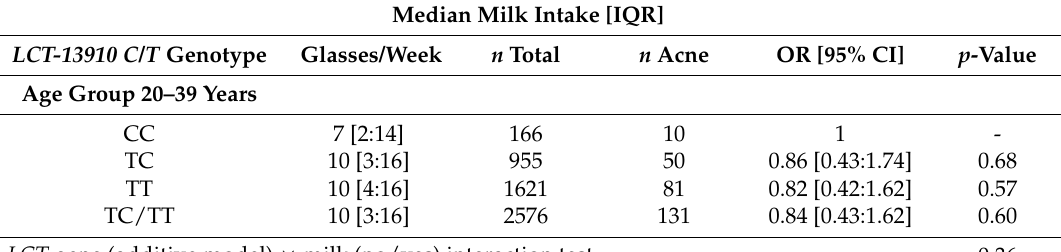
Table 5. Odds ratio for acne by LCT-13910 C/T genotypes.